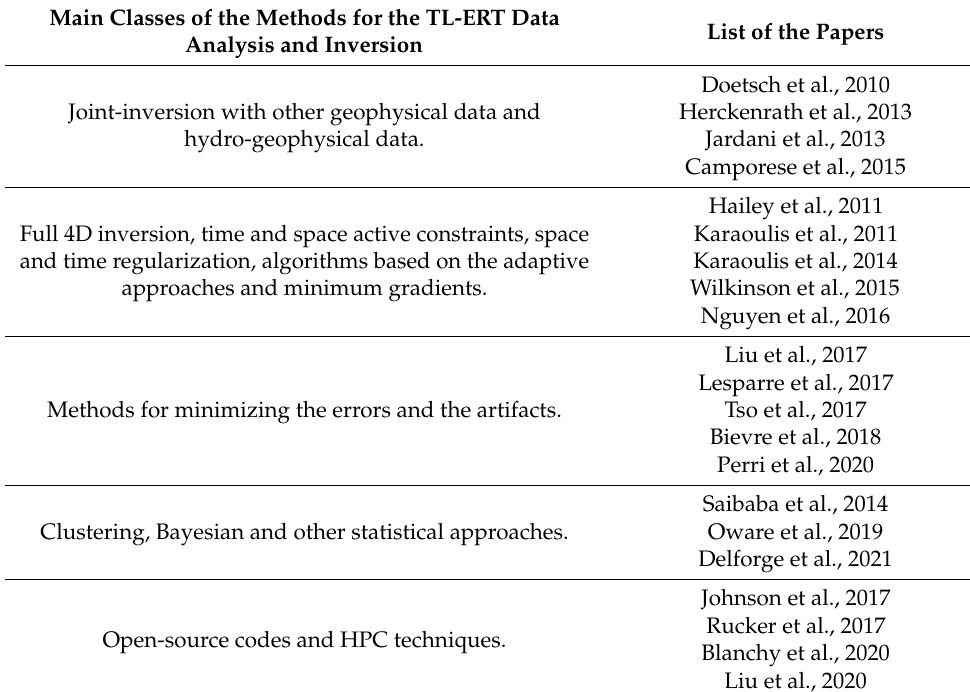
Table 1. Simplified classification of the different approaches and methods adopted in the TL-ERT data processing and inversion. The scheme is based on the analysis of a selected list of papers published in the last ten